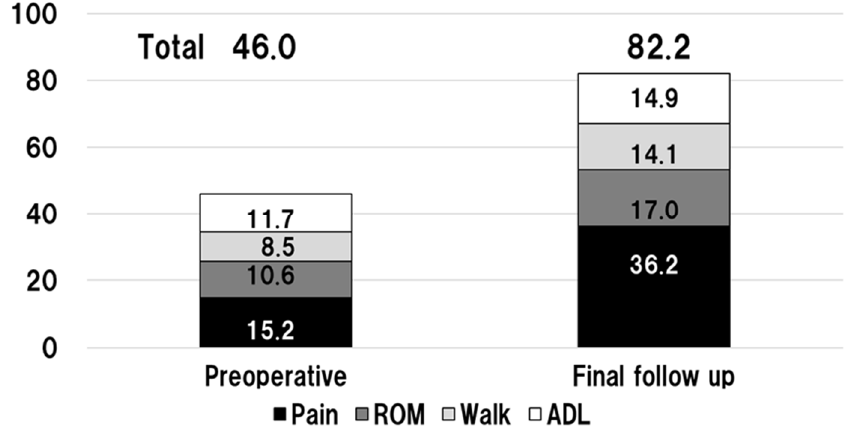
Figure 3. Clinical hip function outcomes using the Japanese Orthopaedic Association (JOA) hip score preoperatively and at the final follow-up.